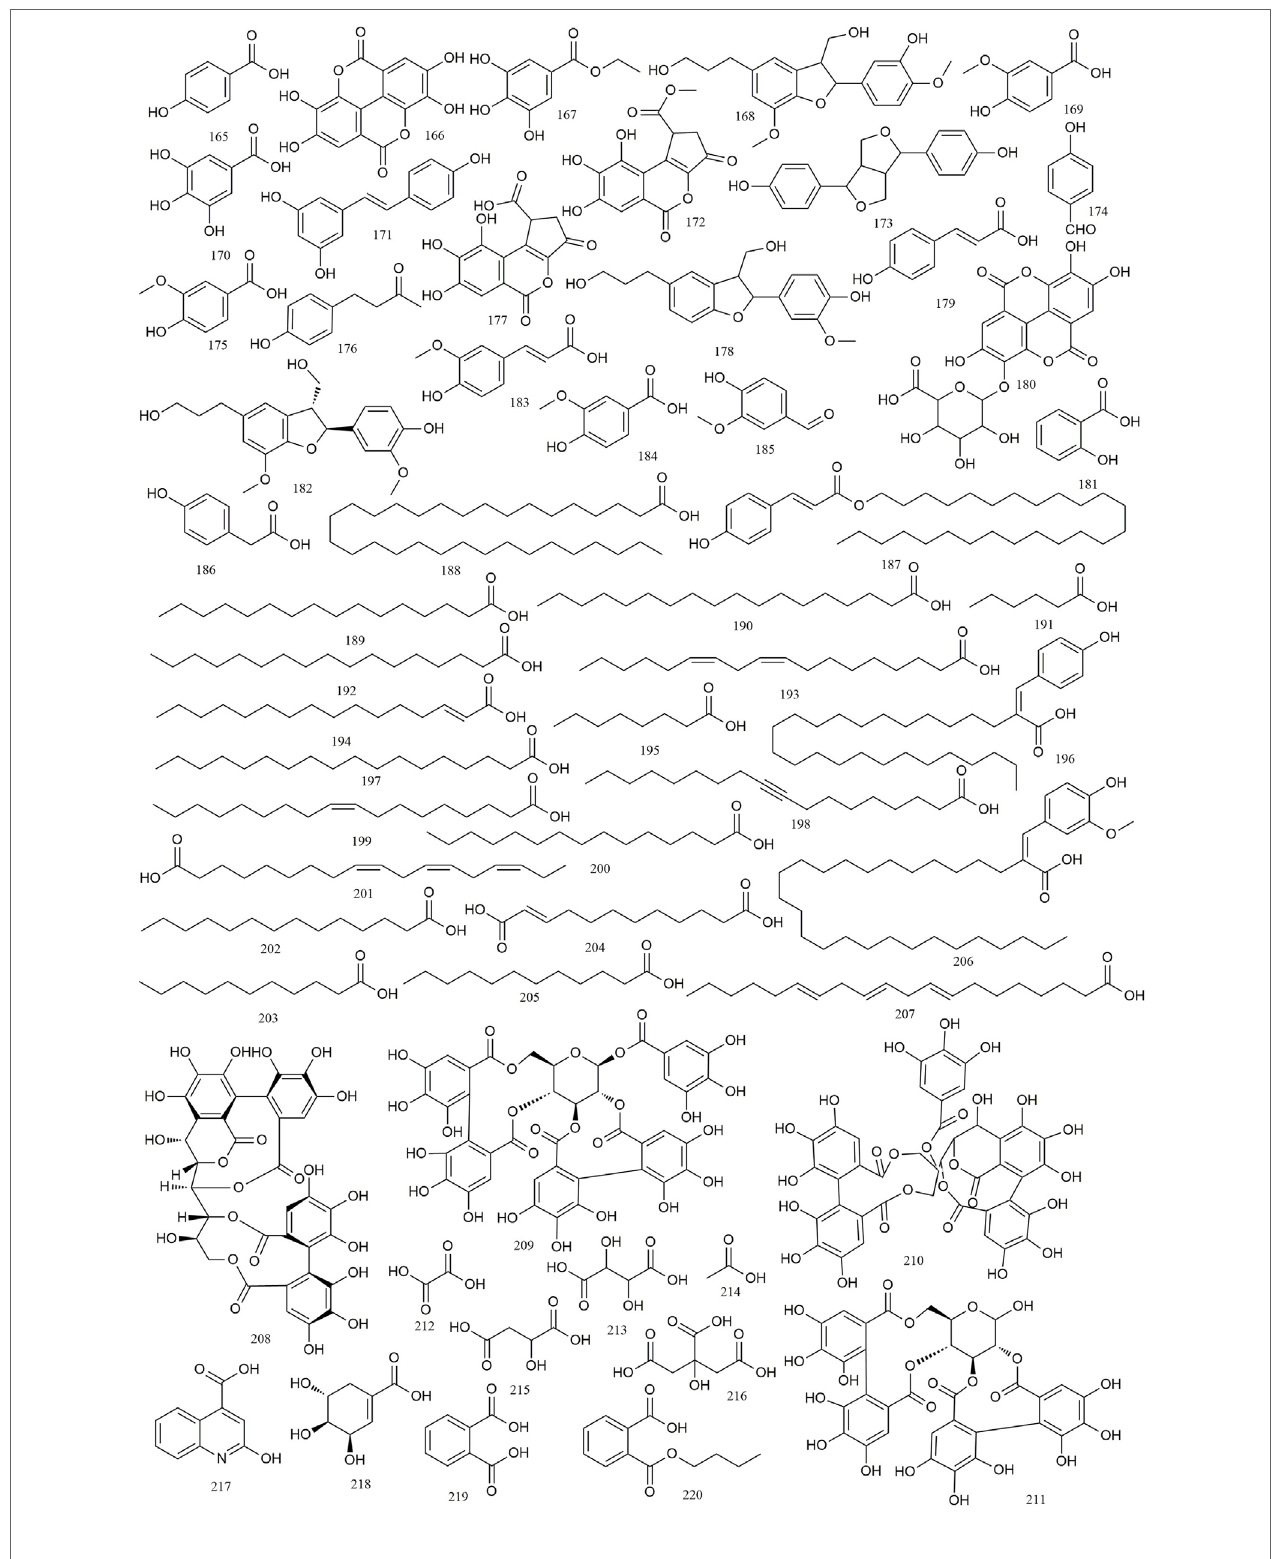
FIGURE 8 | Chemical structures of organic acids (165–220) isolated from R. chingii